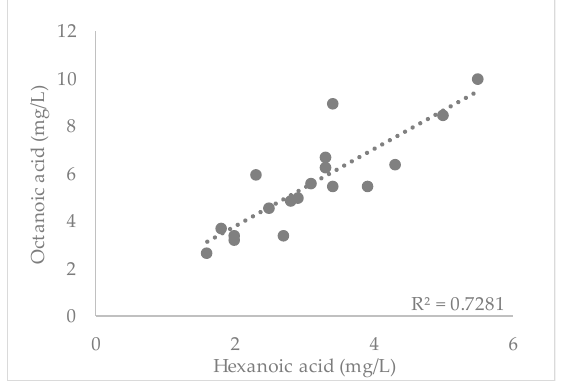
Figure 2. Correlation between the concentrations (mg/L) of octanoic acid and hexanoic acid (in eighteen fresh beers: A–R).